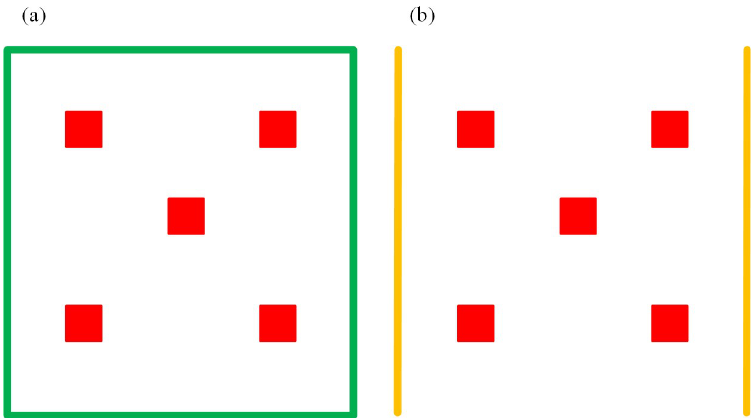
Fig 1. The population investigate method of Lygus pratensis in field. (a) The left picture showed the investigation method of sunflower with different varieties and planting dates, and cotton in the plots. Within green square represent plot, and red indicates sampling points. b) The right picture showed the investigation method in cotton field with and without sunflower strips. Yellow lines are sunflower strips, and red indicates sampling